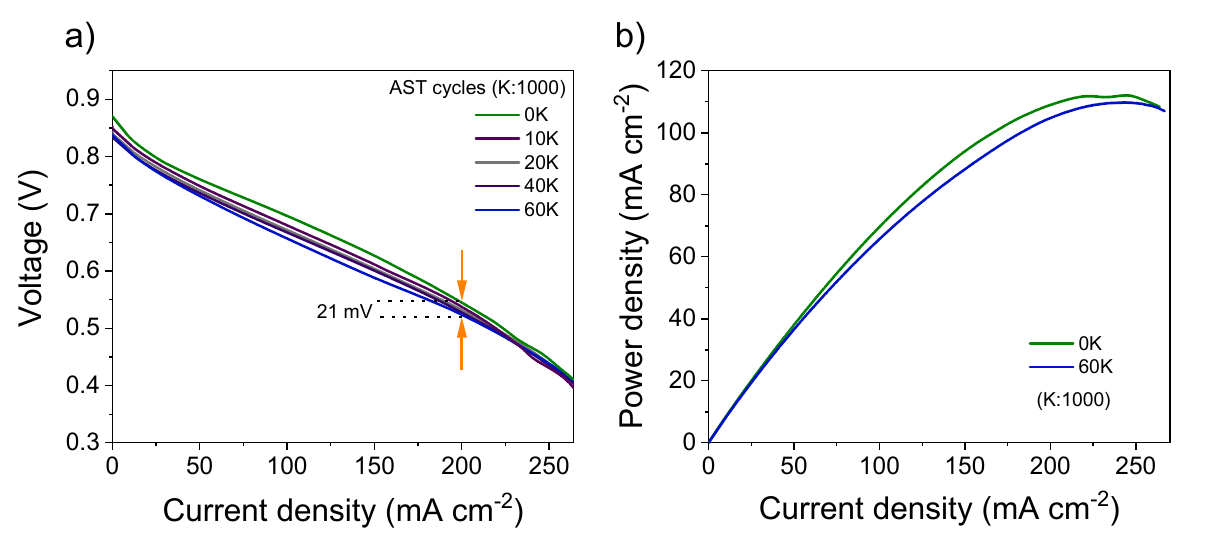
Figure 6. ( a ) Fuel cell polarisation curves at various cycles of operation under AST, ( b ) comparison of power density between first cycle (0 K) and final cycle (60 K). Performance was monitored in the voltage range of 0.5–0.6 V at the current density of 200 mA cm − 2 . Table 1. Performance of various Pt and Pt-alloy cathode catalysts recently reported. Cathode Catalyst Anode Catalyst Performance Degradation